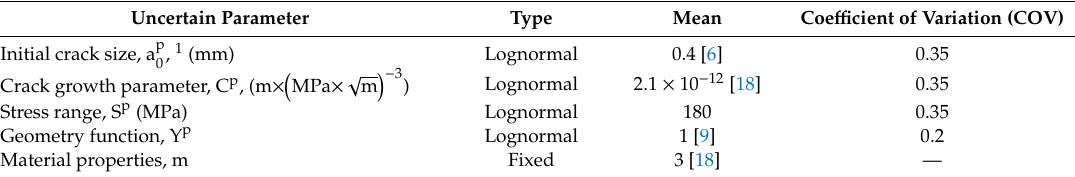
Table 1. Statistics of the